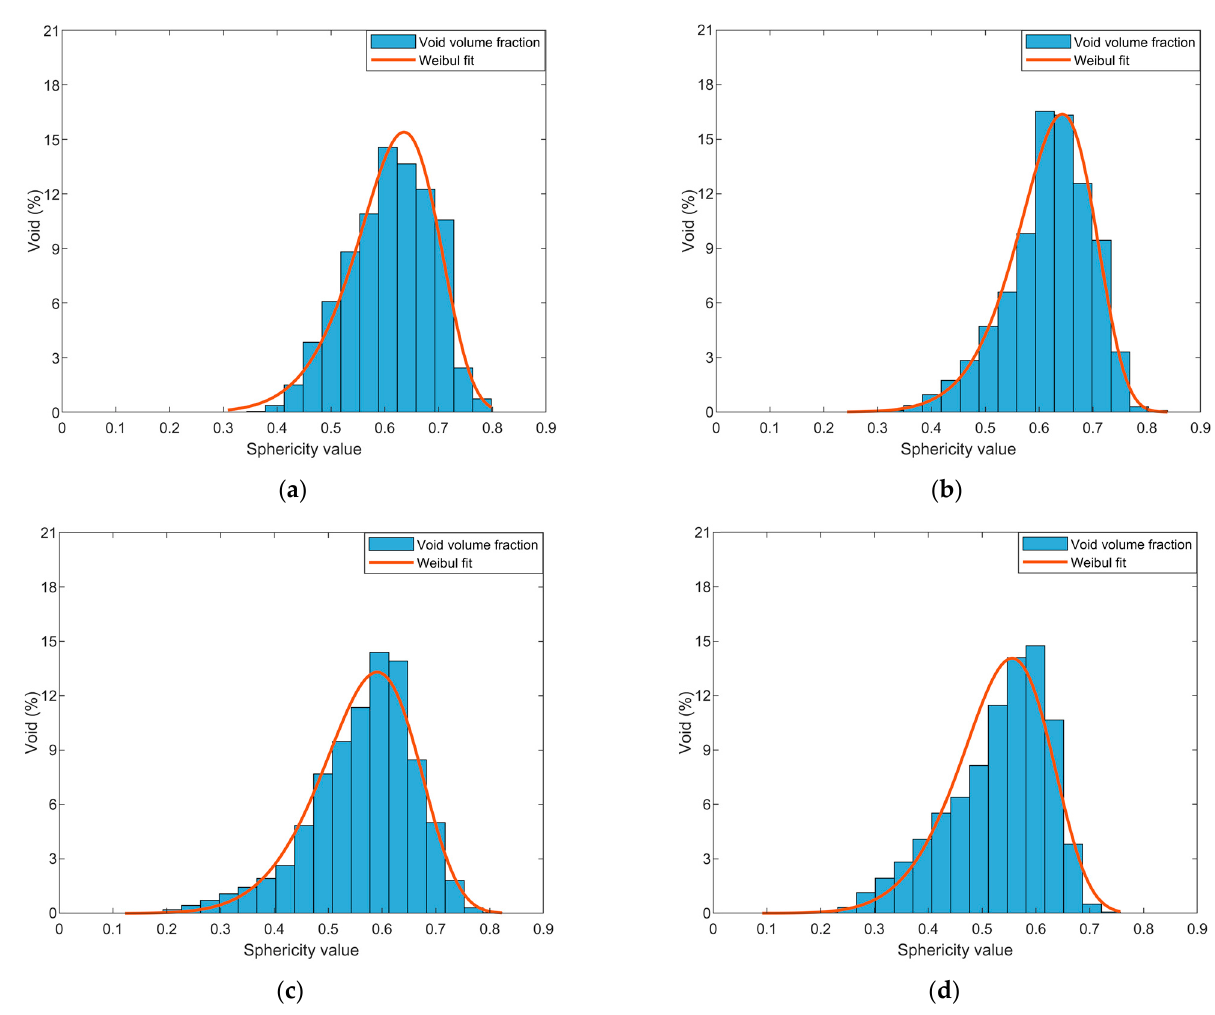
Figure 10. Fraction of voids sphericity histogram and Weibull fit of ( a ) a SCF/ABS pellet ( b ) extruded strand ( c ) regularly deposited bead, and ( d ) roller-compressed bead.